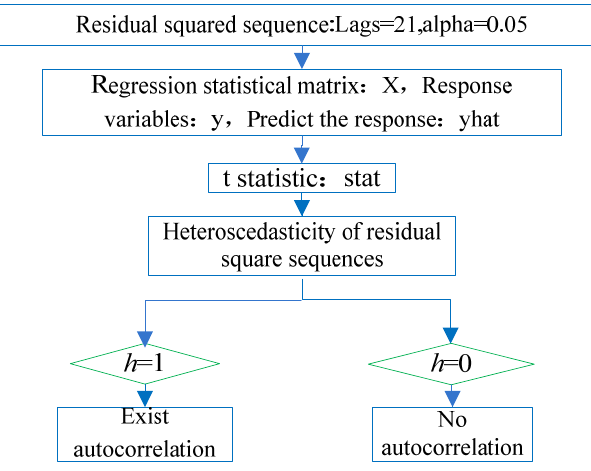
Figure 7. Heteroskedasticity ARCH test process.